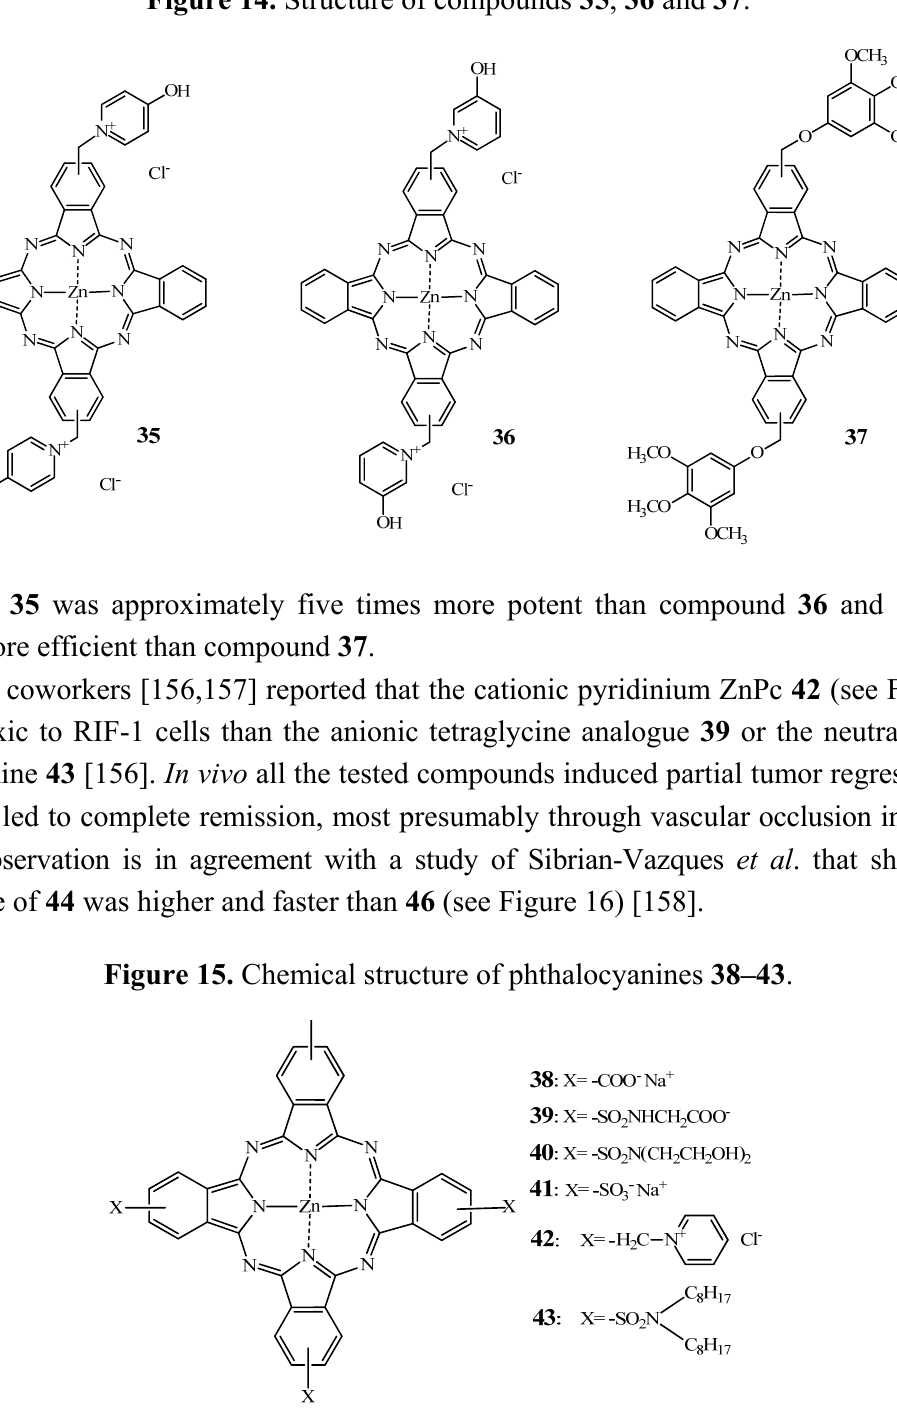
Figure 14. Structure of compounds 35 , 36 and 37 .